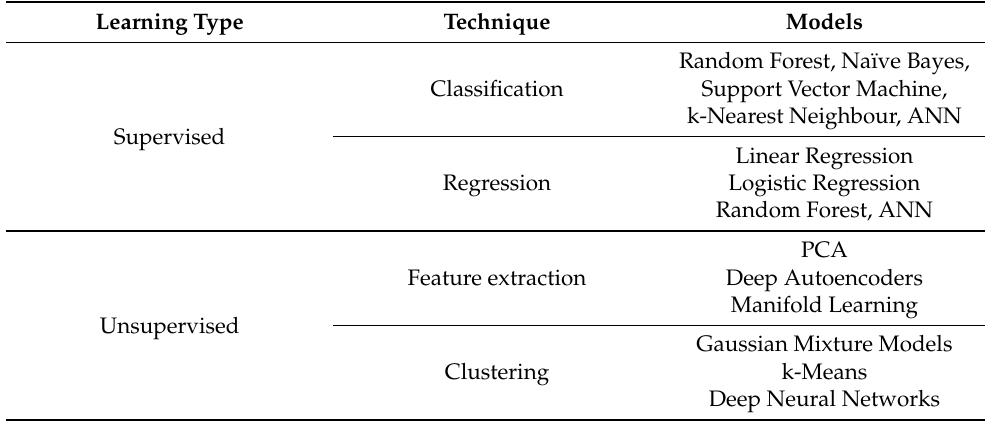
Table 1. Summary of the main machine-learning